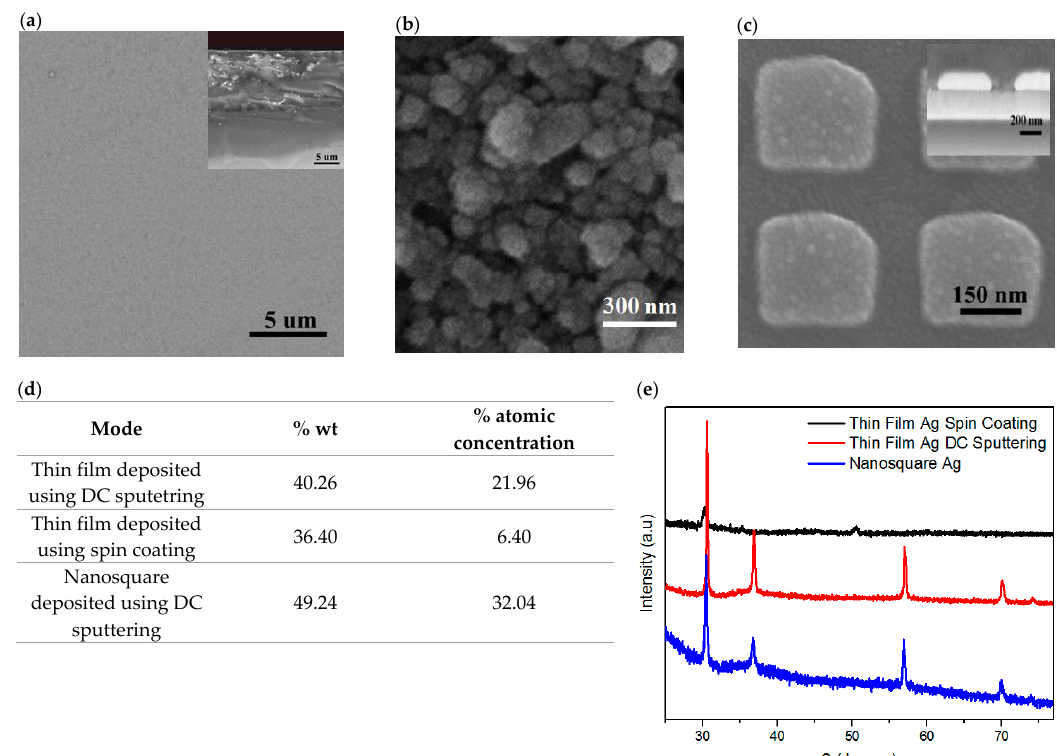
Figure 2. SEM images of ( a ) top view and side view of the Ag thin-film deposited using DC sputtering, ( b ) top view of the Ag thin-film deposited using spin coating, ( c ) top view and side view of the arranged Ag nanosquares array, ( d ) the EDS analysis results the Ag nanosquare array and Ag thin-films deposited using DC sputtering and spin coating, and also ( e ) XRD measurement result of the Ag thin-film and Ag nanosquare array electrodes